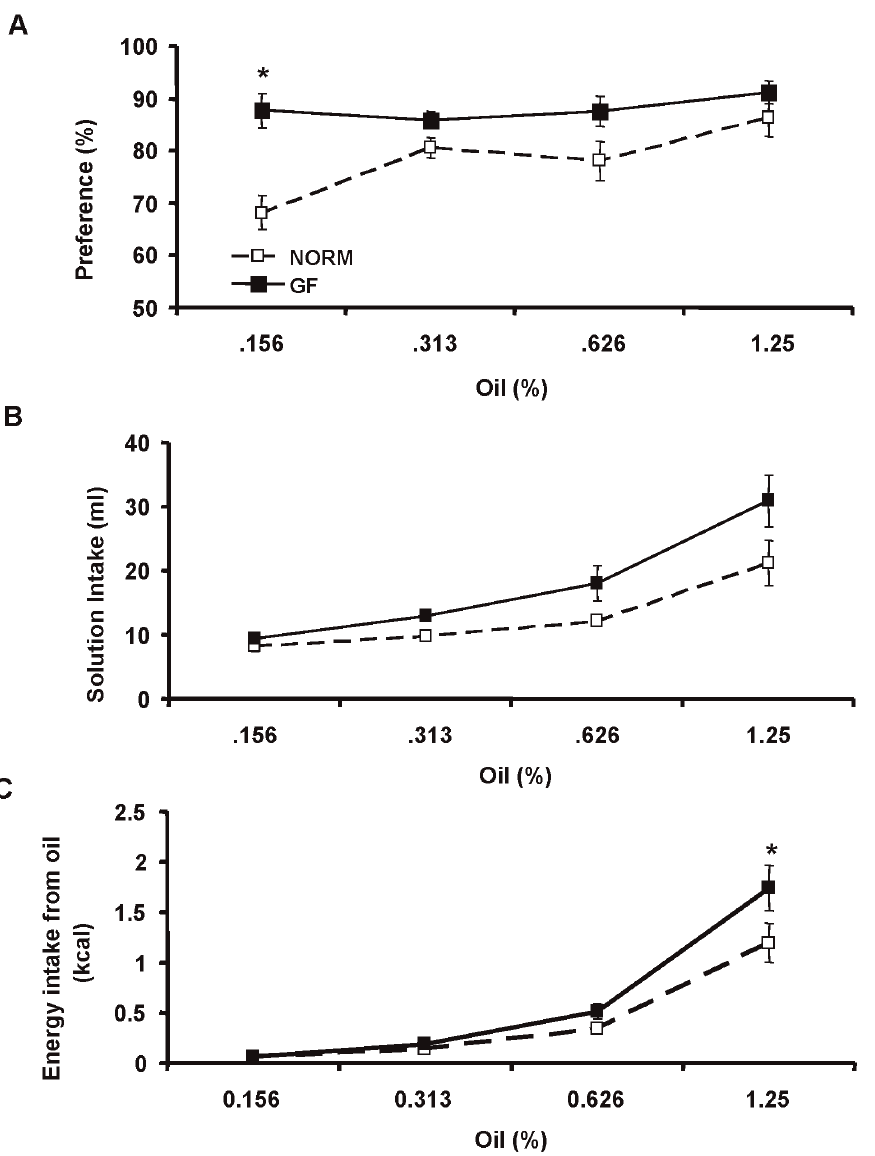
Figure 1. Preference (A), raw intake (B), and calorie intake from intralipid emulsions (C) in GF and NORM C57B6/J mice during 48-h two-bottle intralipid vs. water tests. (A) GF mice preferred the lowest concentration (0.156% oil) of intralipid emulsion test more than NORM mice. (B) Intake of intralipid emulsions was similar at each concentration tested, but increased overall in GF mice relative to NORM controls. (C) GF mice consumed more energy from the highest concentration (1.25% oil) of intralipid emulsion tested. Data are expressed as means 6 SEM. *P , 0.05 compared to NORM.